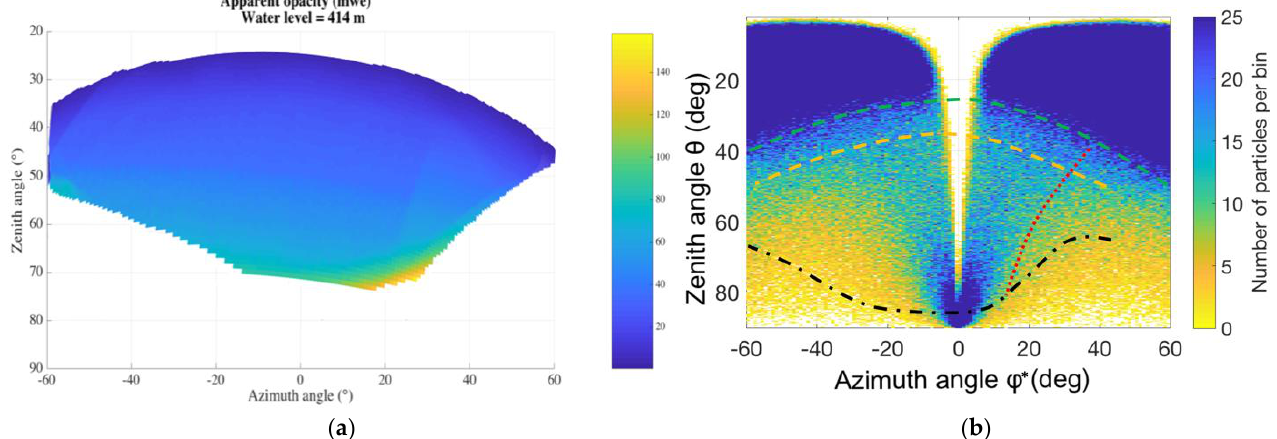
Figure 5. ( a ) Apparent opacity of the targeted volume with a water level of 414 m.a.s.l., the detector tilt was corrected. ( b ) Muons measured coming from the direction of the target volume.